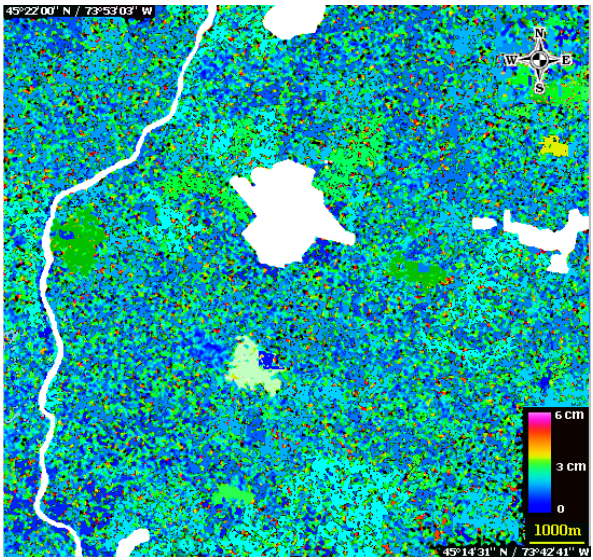
Fig. 12. Volumetric humidity map at pixel scale.